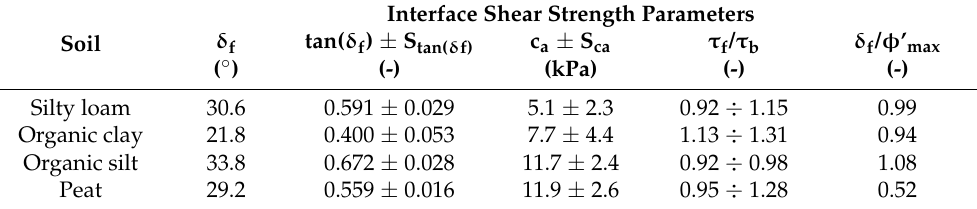
Table 6. Friction characteristics of rough concrete–soft soil